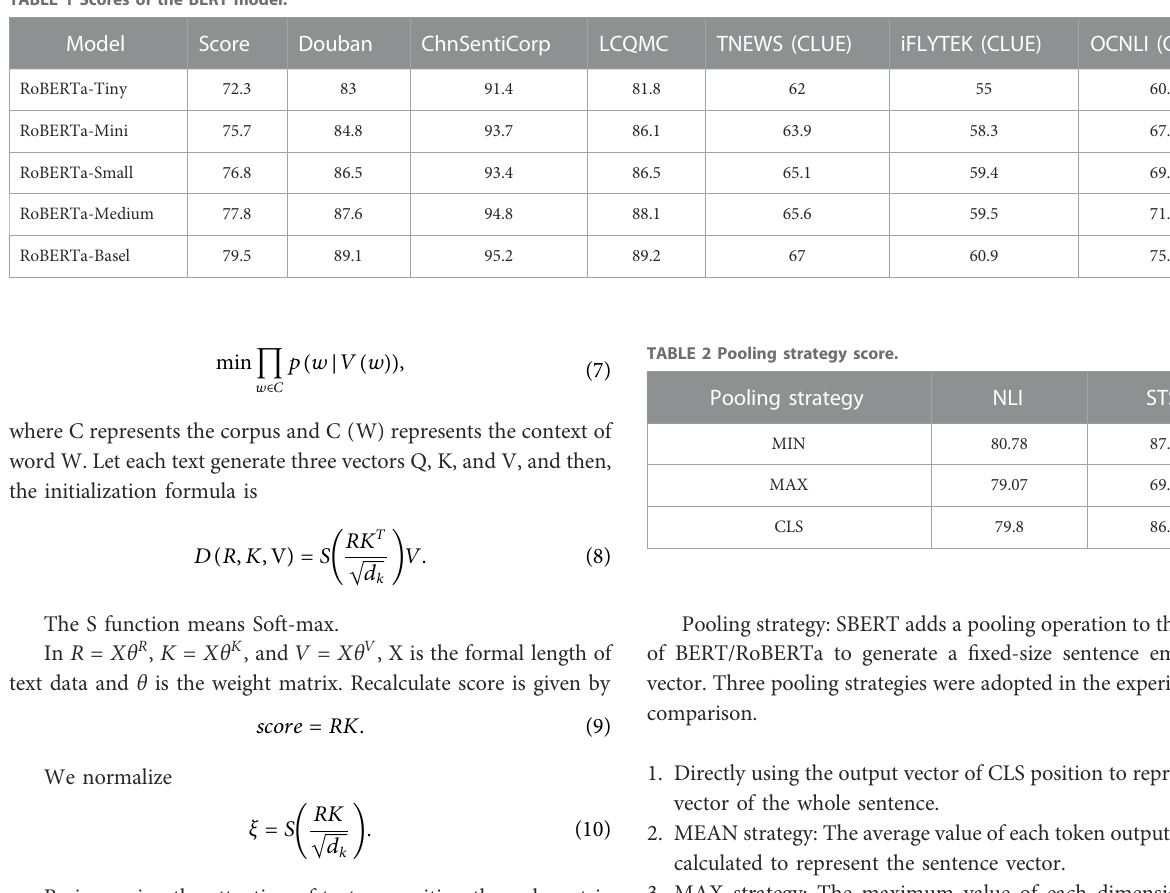
TABLE 1 Scores of the BERT model.